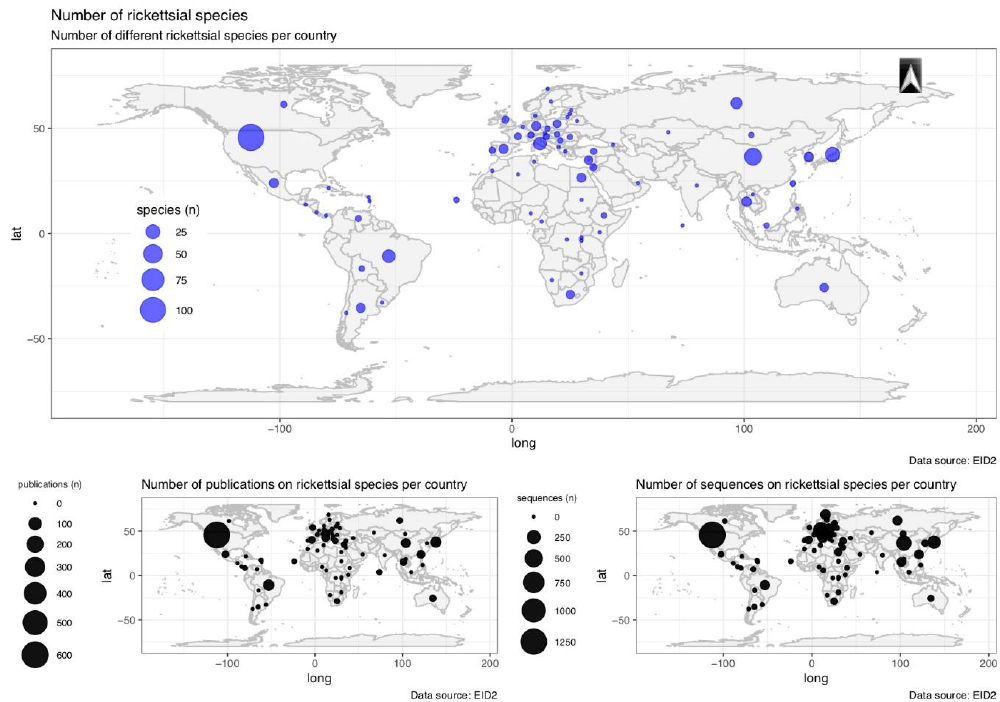
Figure 3. Geographical distribution of the richness of rickettsial species in the EDI2 database [20]. The hotspots of rickettsial species richness reflect the sampling effort as estimated by the number of publications (bottom left) or the number of sequences (bottom right) in the EDI2 database.